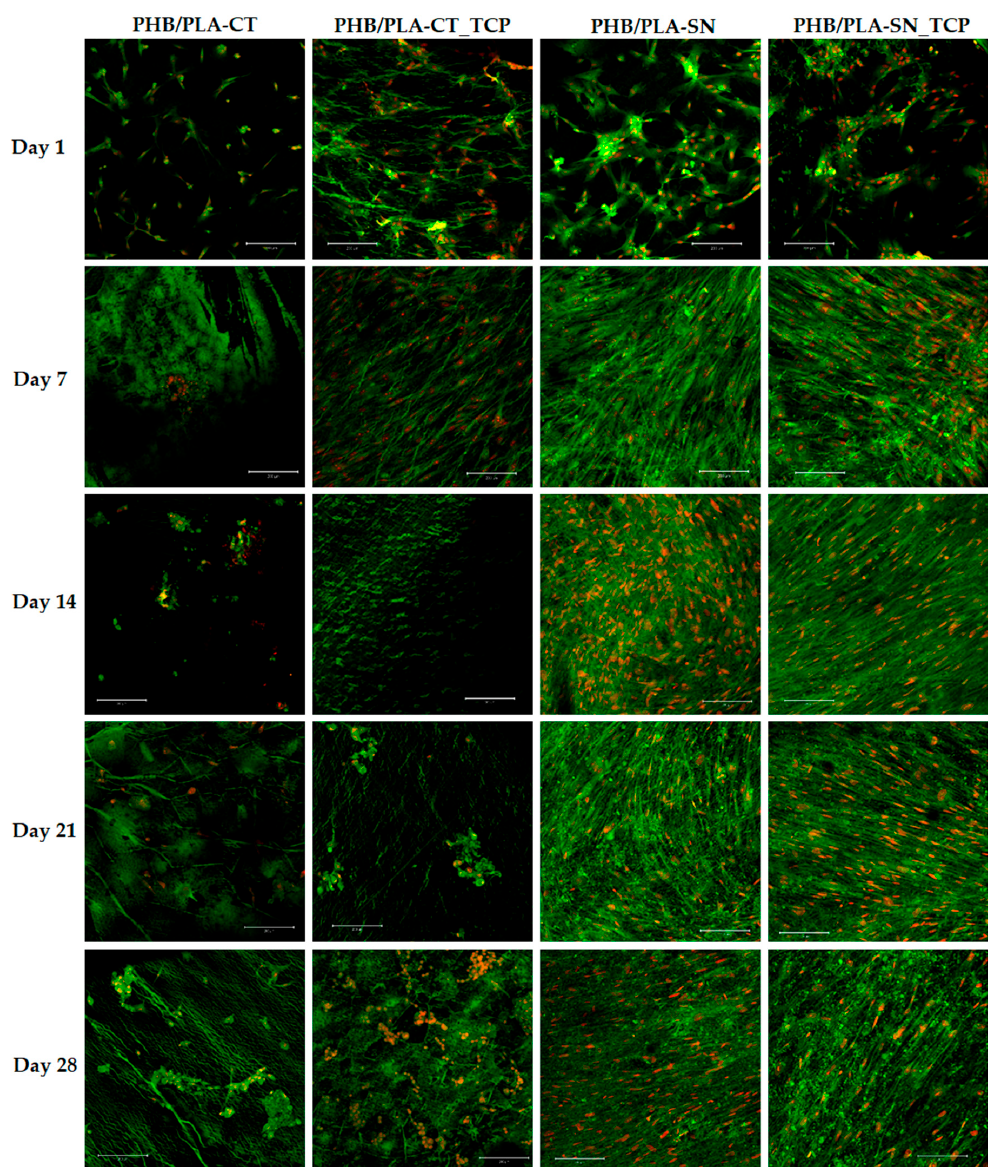
Figure 6. hMSCs on scaffolds from tested materials, magnification 100×, the bar is 200